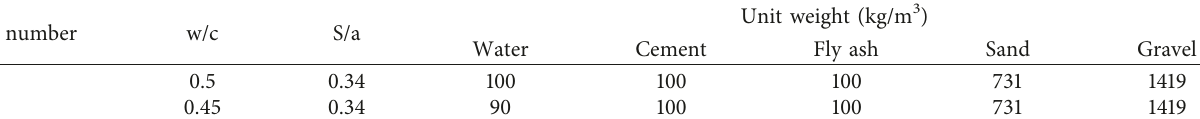
Table 2: Mixture proportion of concrete.